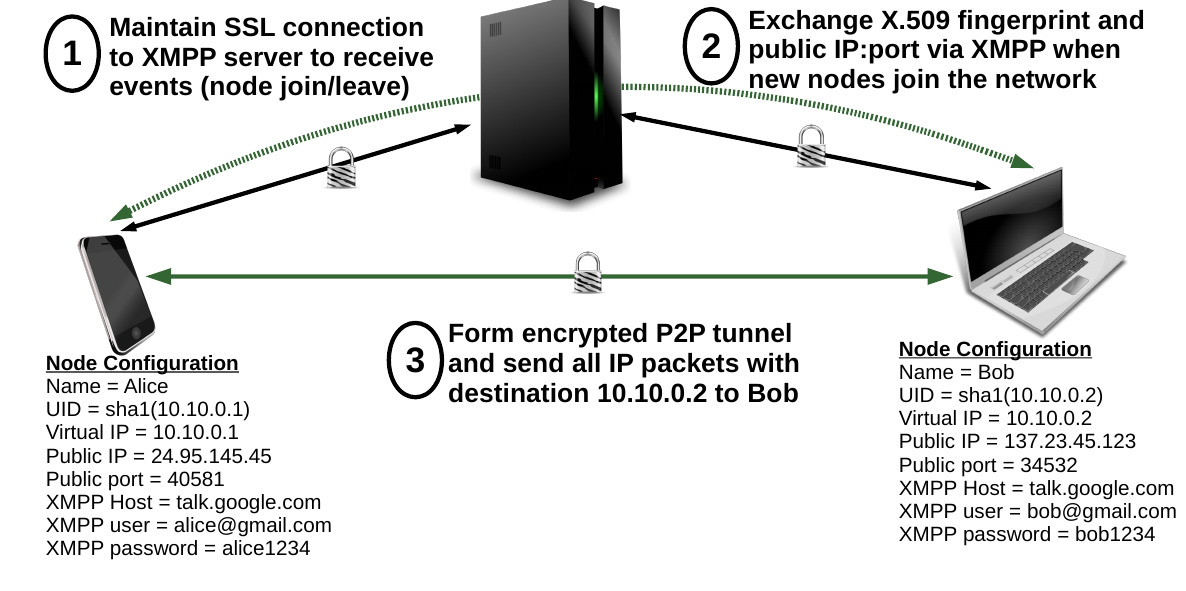
Figure 5. Bootstrapping TinCan